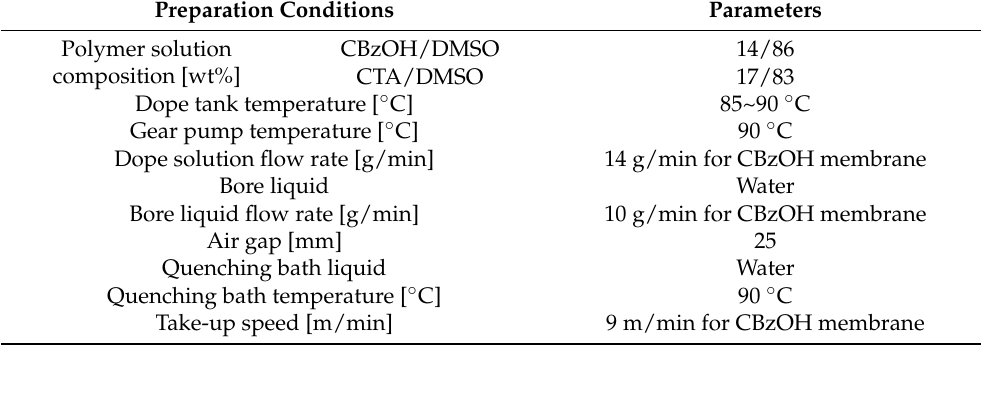
Table A5. Preparation conditions of hollow fiber membranes by NIPS method.